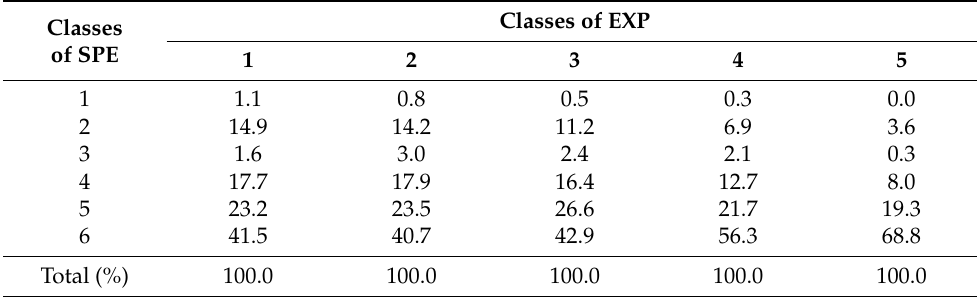
Table 11. Percentage incidence of every SPE classes within the same EXP class (calculated as percentage of LAUs’ number for each SPE class into the same EXP class on the total number of LAUs falling in that EXP class) for data of the second census date